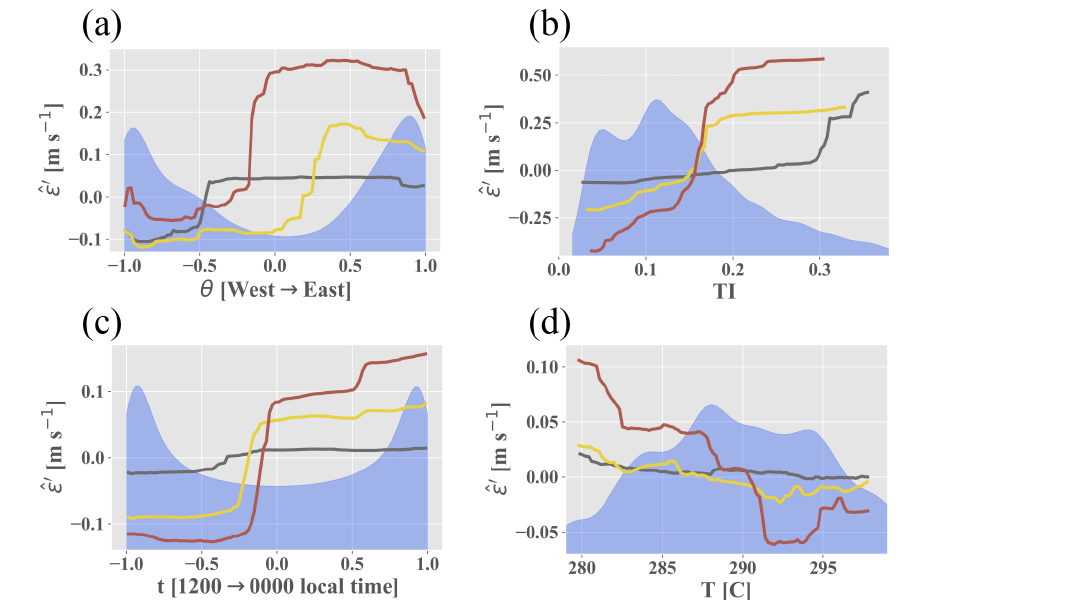
Figure 5. Lines show dependence between the random forest prediction ˆ ε (cid:48) and (a) the east–west component of θ , (b) TI, (c) the noon– midnight component of t , and (d) T . Blue shading shows variable distribution. Arrows in (a) and (c) correspond to direction (on the x axis) of the normalized oscillatory